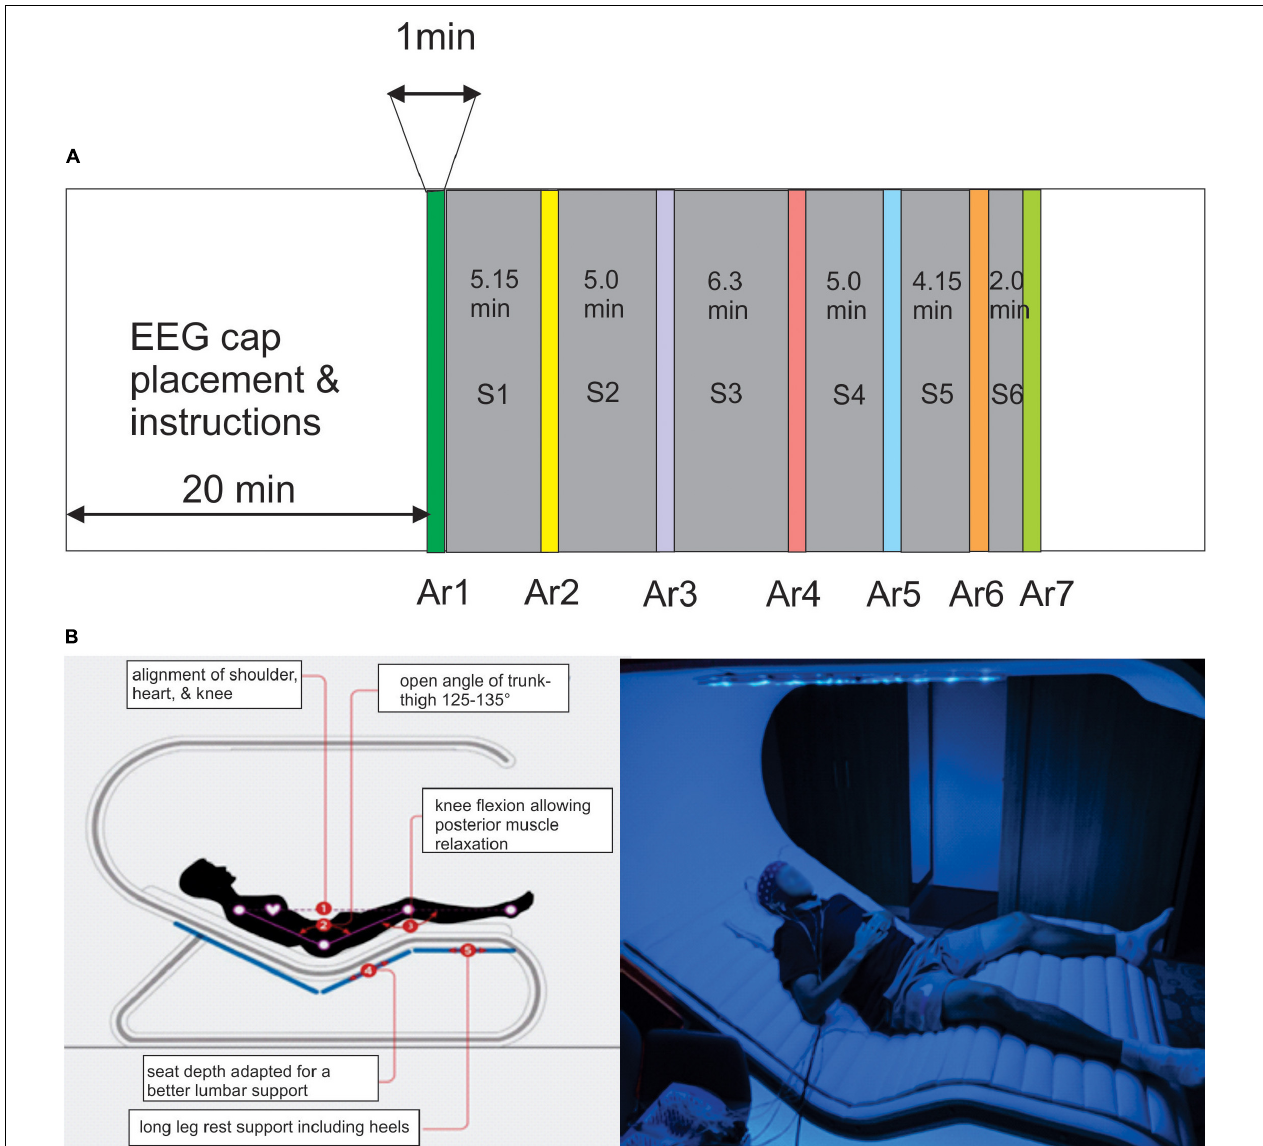
FIGURE 1 | (A) The timing of the Rebalance (RB) session consisted of the succession of six modules interrupted by the arrest reaction (AR) testing (AR2–AR7) during which the power of the alpha oscillation was measured, AR1 is the control testing realized before the session. (B) Illustration of the RB impulse system in which the participants are comfortably placed in supine position and equipped with the EEG cap recording and